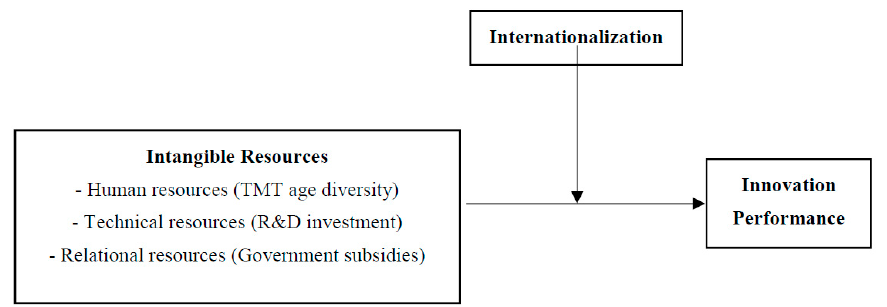
Figure 1. Research Figure 1. Research model.